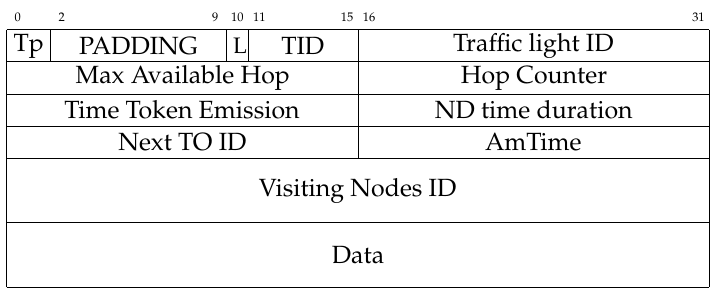
Figure 3. Token packet structure.